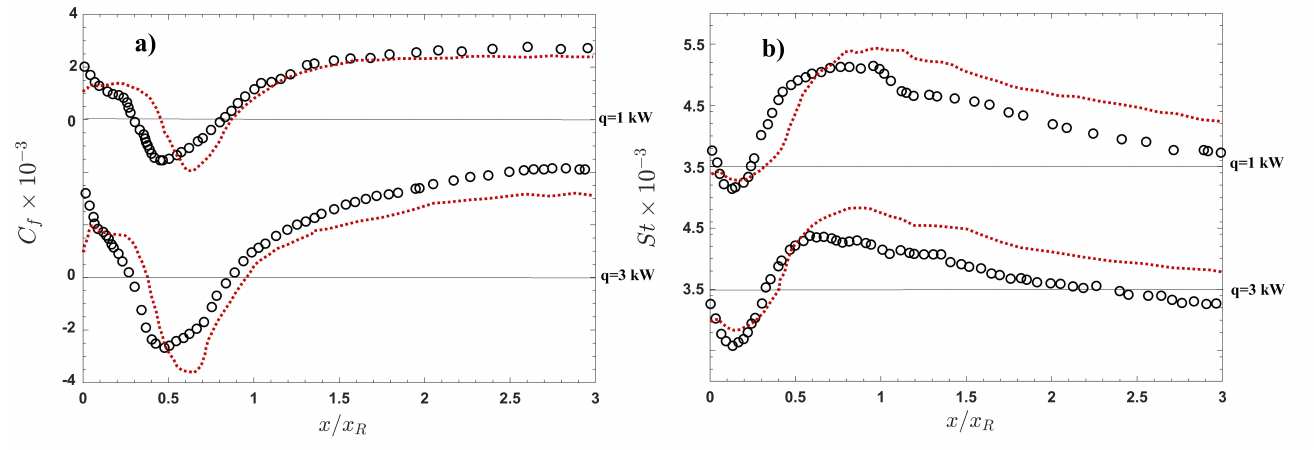
Figure 11. The distribution of ( a ) the mean skin friction and ( b ) Stanton number for the cases with intense wall heat transfer. IDDES (red dotted line), corresponding experiment